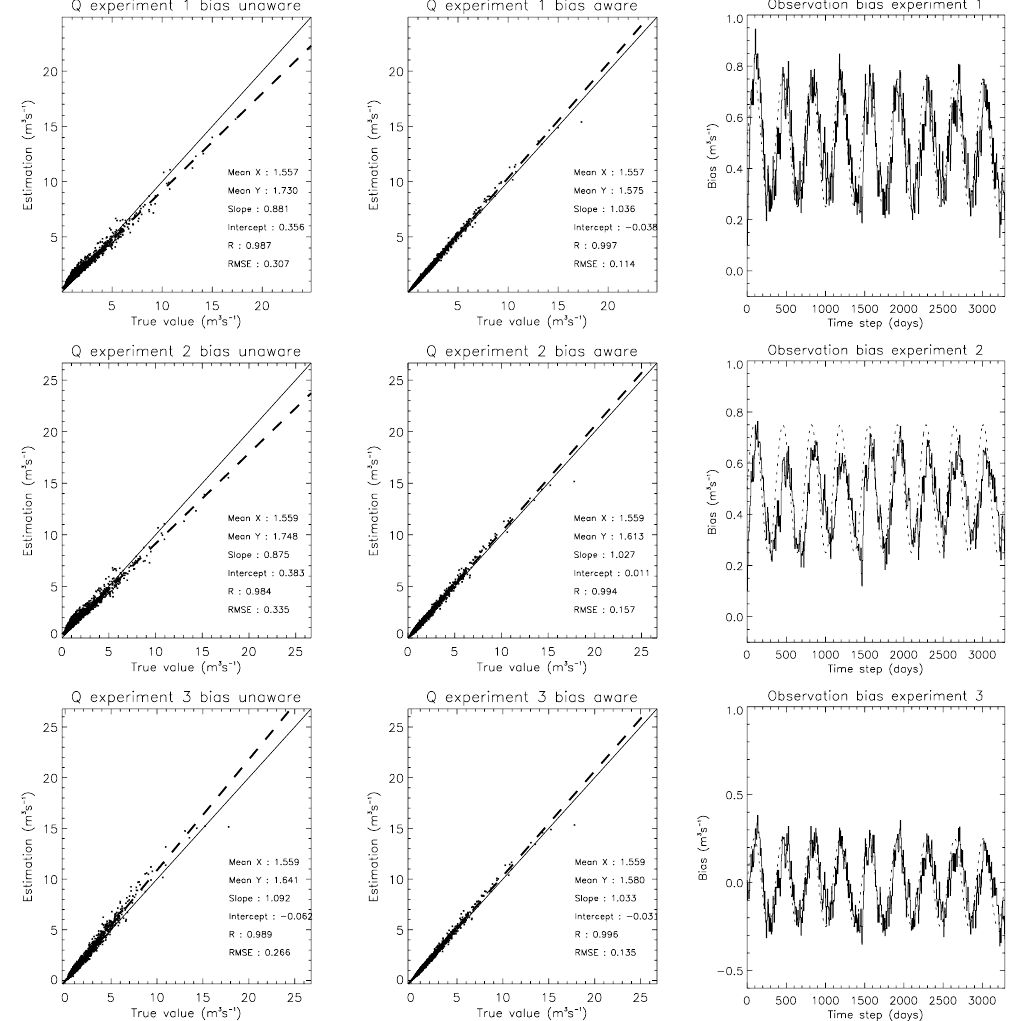
Fig. 10. Comparison of the estimated discharges obtained using the bias-aware and a bias-unaware EnKF, and the evolution of the observation bias throughout the simulation – both for the sinusoidal observation bias experiment. The dashed lines are the regression lines; the solid lines the 1:1 line. For the bias estimation, the dotted lines refer to the true